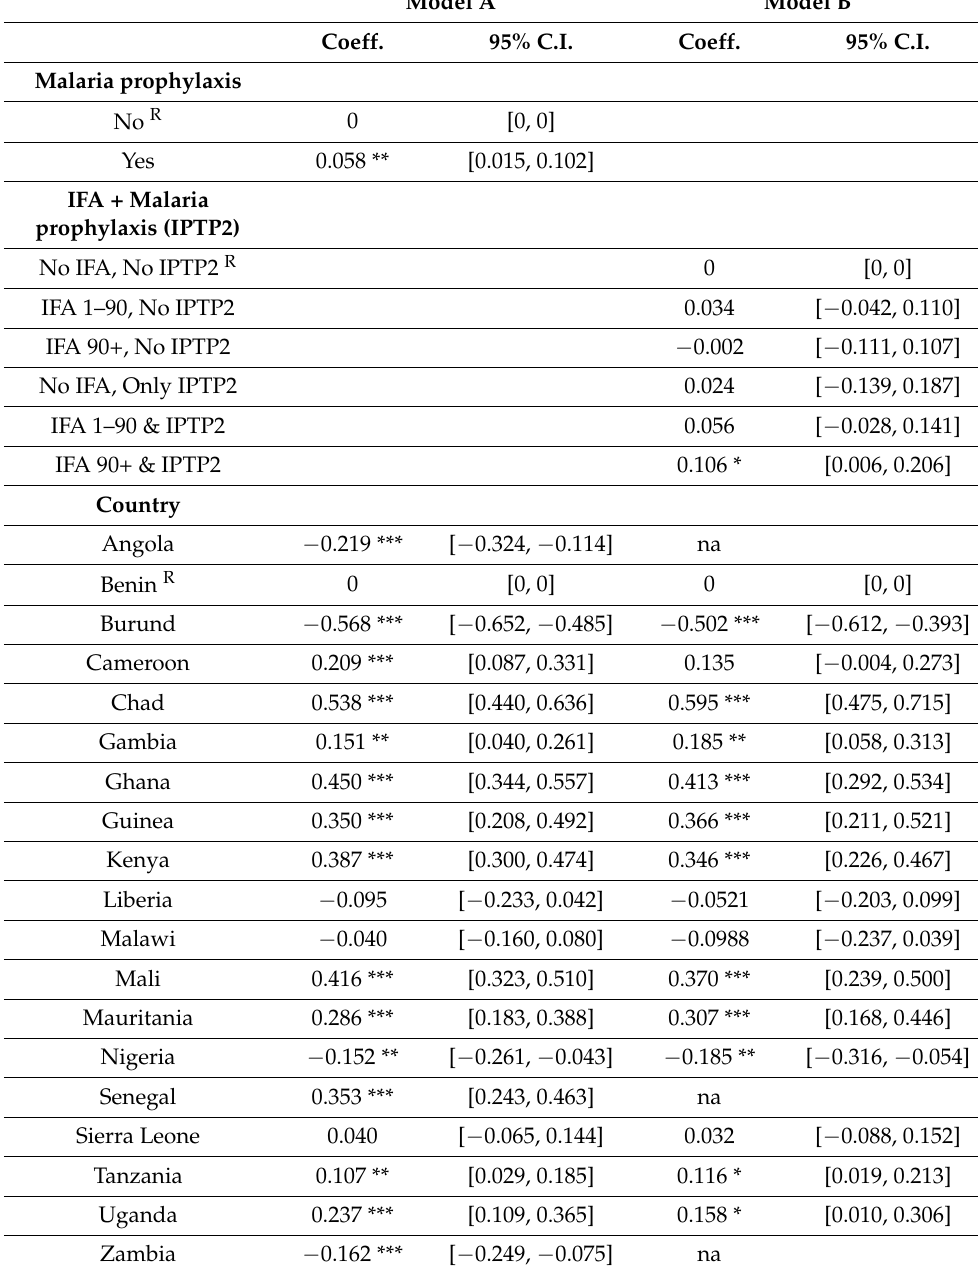
Table 7. Multivariate linear regression model on HAZ scores. Model A Model